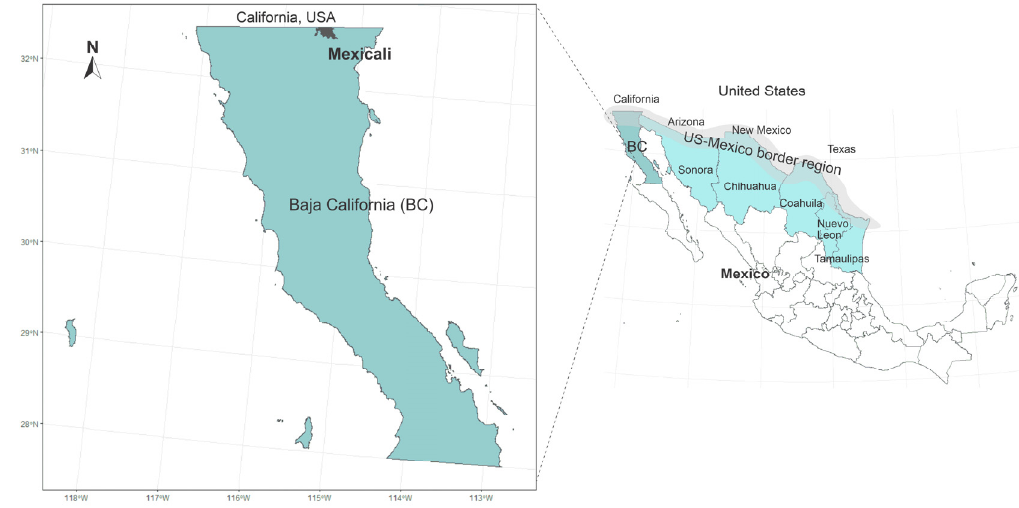
Figure 1. The geographic location of Mexicali within the US–Mexico border region.